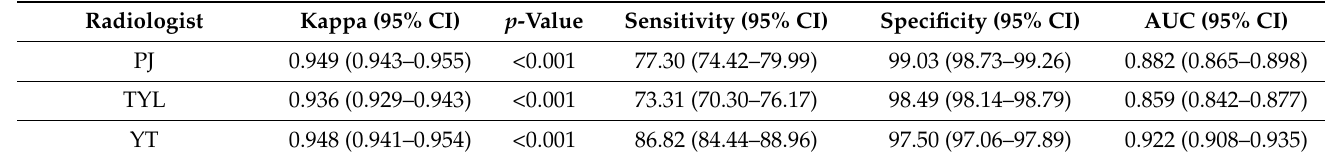
Table 8. Radiologist sensitivity, specificity, and AUCs for two-grade (normal versus low/high-grade) MESCC per CT image.